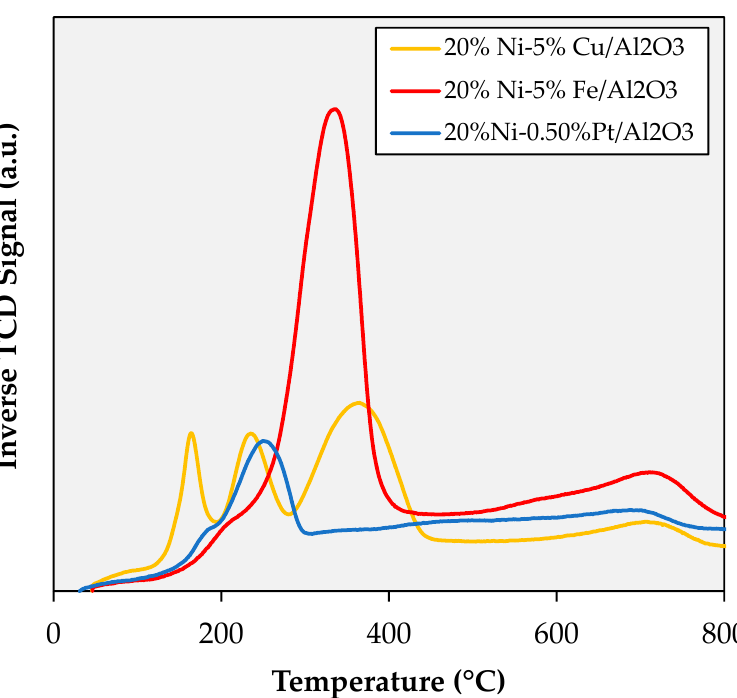
Figure A12. TPR profiles of the spent catalysts after calcination in air at 450 °C for 5 h. Variations in the baseline were magnified by the presence of the SiC diluent (which further reduced the limited amount of sample available for analysis); however, all reduction events are clearly resolved.